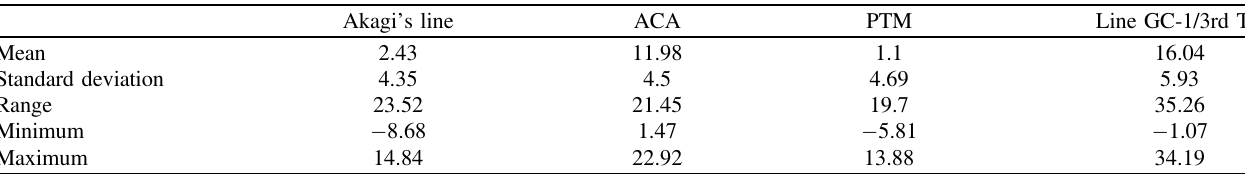
Table 5. Comparison of tibial reference axes relationships with